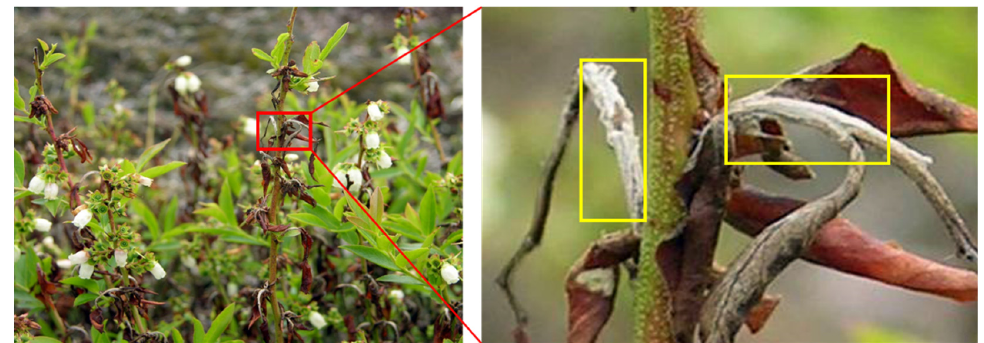
Figure 1. An example of field-taken images of mummy berry disease with the complex background of blueberry bushes. The red square marks the area in the left panel. The same image is zoomed in and depicted in the right panel, where yellow squares identify the presence of conidia.